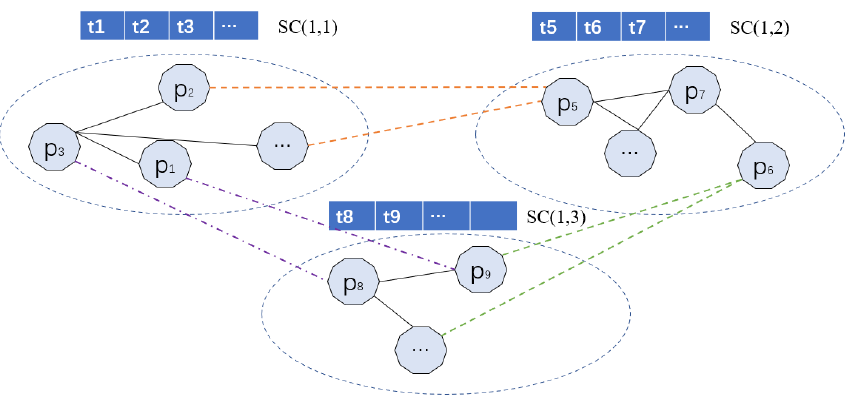
Figure 2. Schematic diagram of capability